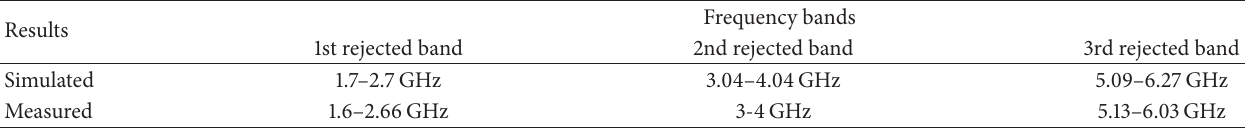
Table 2: The rejected bands achieved with the proposed